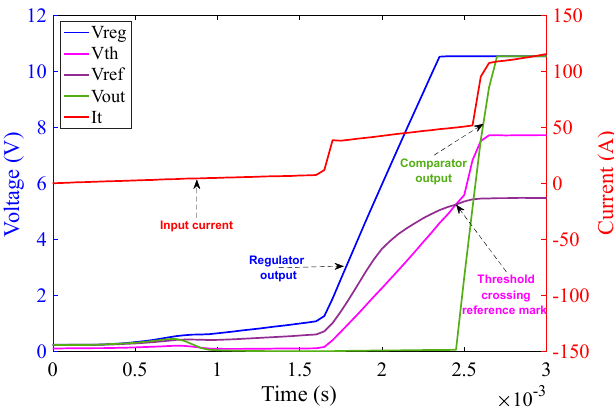
Figure 19. 1 Ω burden circuit operation at 100 A (rms) input current over the duration of 3 Figure 19. 1 Ω burden circuit operation at 100 A(rms) input current over the duration of 3 ms.